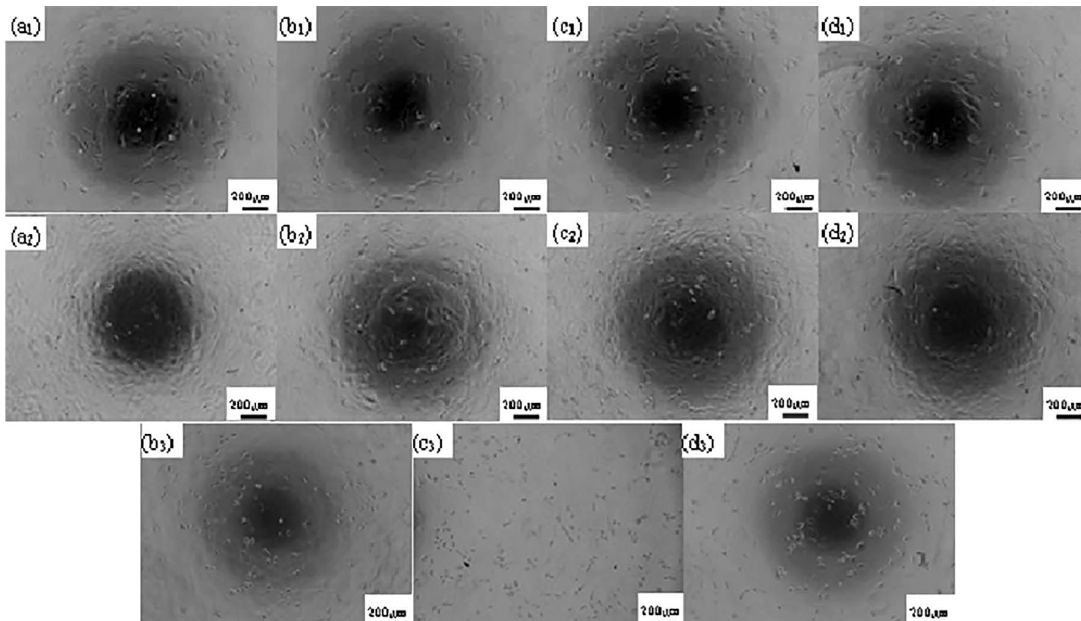
Figure 6. The morphologies of mouse osteoblasts cultured in extraction medium after 0 and 3 days (a) control group, (b) Zn-1.5Mg, (c) Zn-1.5Mg-0.2Y, (d) Zn-1.5Mg-0.5Y 1: 0 day; 2: 3 days for 50% extraction medium; 3: 3 days for 100% extraction